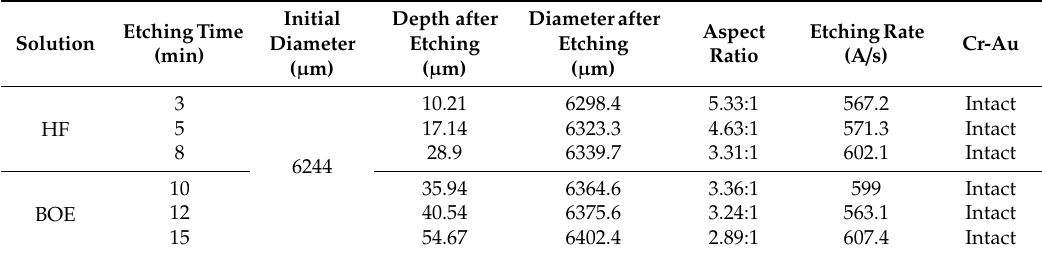
Table 7. Results of wet etching with the protection of